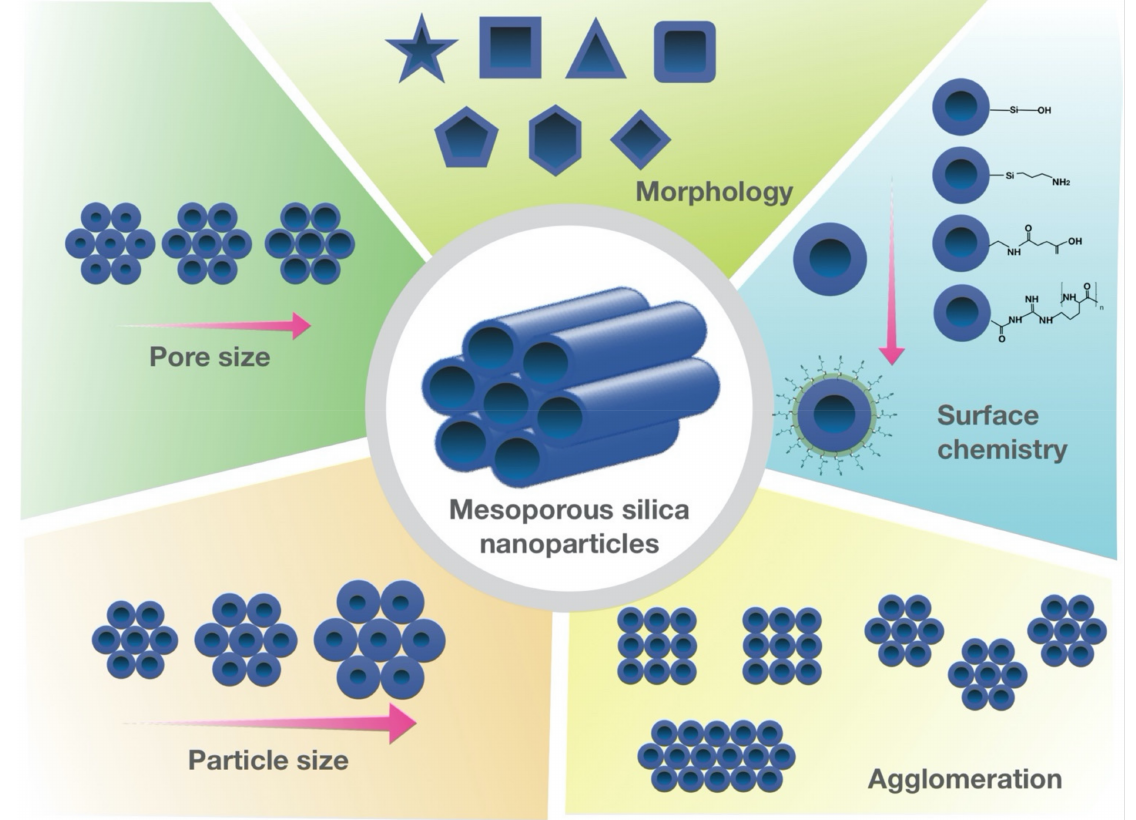
Figure 1. Tunable physicochemical properties of MSNs. Schematic illustration of MSNs with various pore sizes and structures, surface chemistry, agglomeration patterns, and different morphologies.